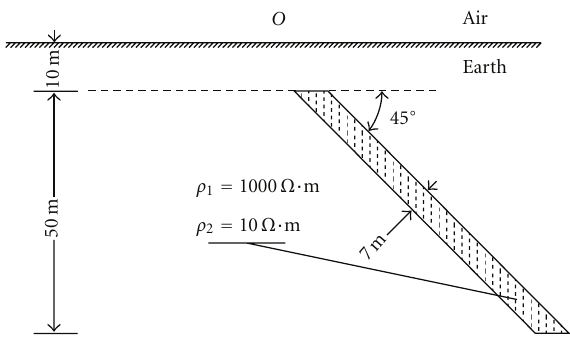
Figure 7: Inclined tabular orebody